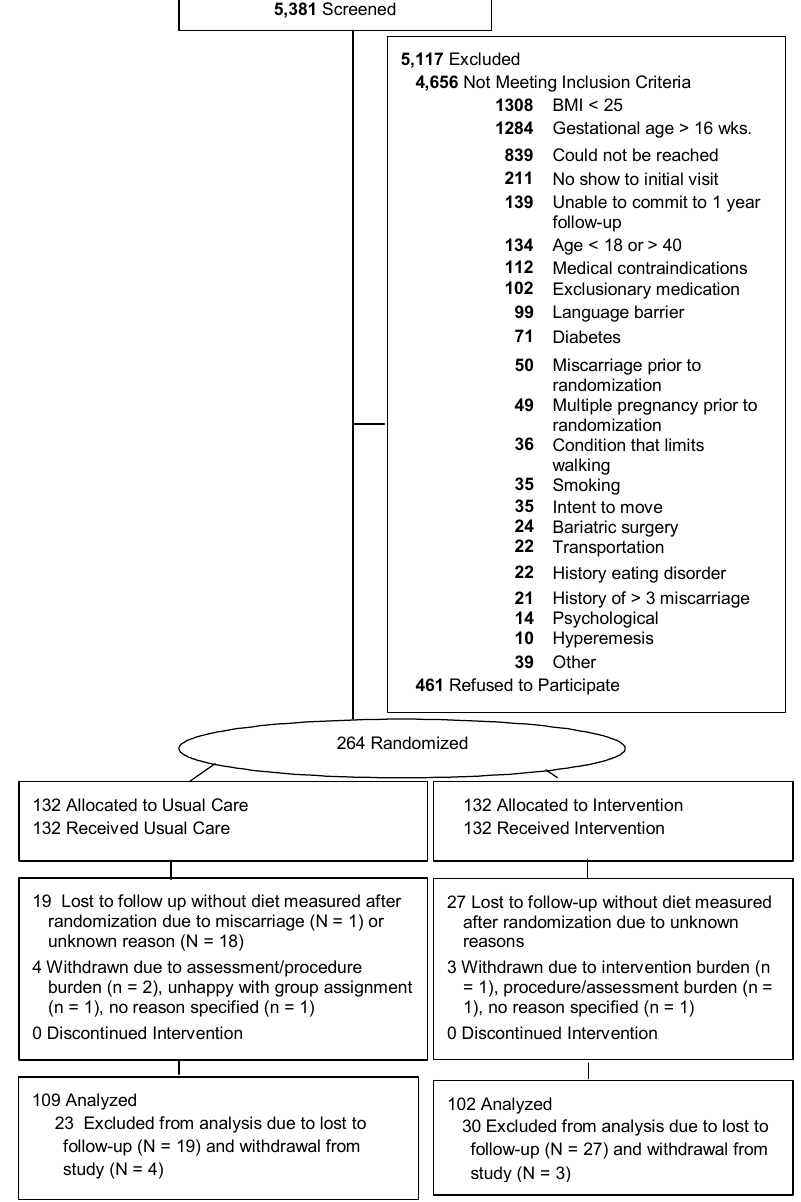
Figure 1. Participant flow and Retention in Healthy Beginnings / Comienzos Saludables. BMI = body mass index